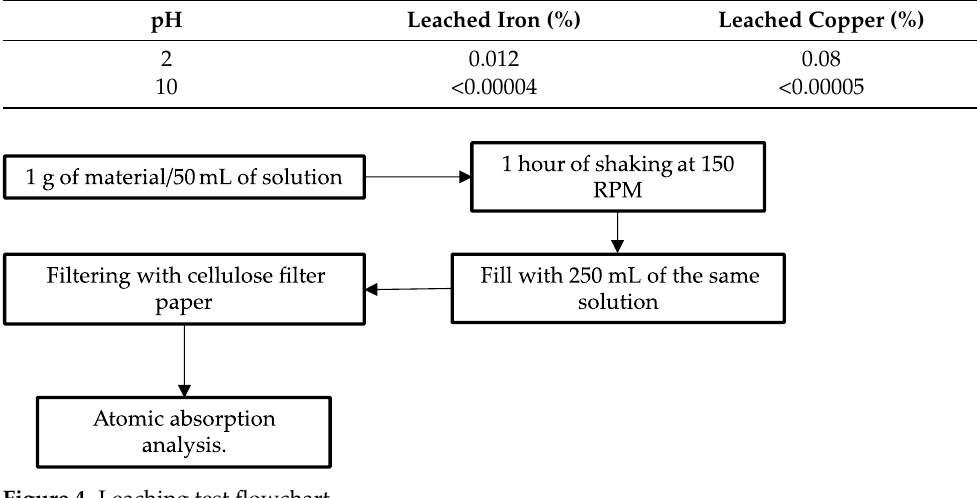
Figure 4. Leaching test